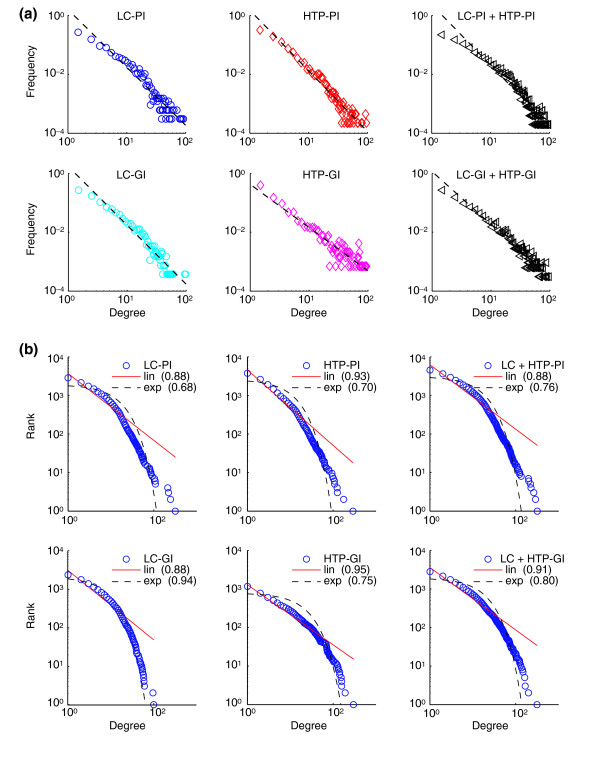
Scale-free degree distribution of physical and genetic interaction networks. (a) Frequency-degree plots of LC, HTP and combined networks. Degree is the connectivity (k) for each node, and frequency indicates the probability of finding a node with a given degree. The linear fit for each plot approximates a power-law distribution. (b) Rank-degree plots of LC, HTP, and combined networks. Each data point actually represents many nodes that have the same degree. The fit of the data to either linear (lin) or exponential (exp) curves is indicated for each plot and the coefficient of determination (R2) is reported in parentheses for each curve fit. Note that although the tail of each distribution exhibits a large deviation, only a small portion of the network is represented by the highly connected nodes in the tail region. For example, approximately 2% of nodes in the LC-PI and HTP-PI networks have connectivity greater than 30.